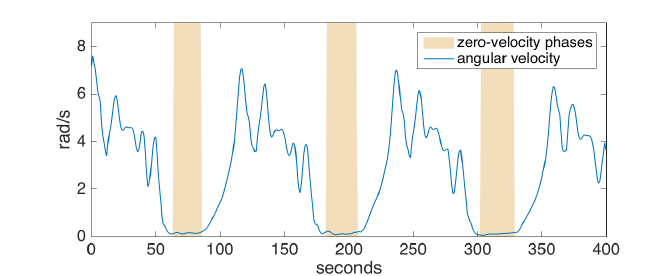
Figure 5. Zero-velocity phase